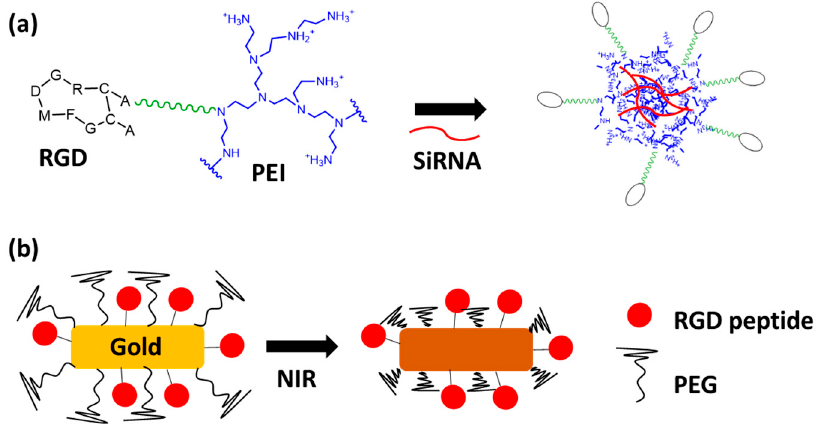
Figure 3. Structures of RGD NPs: ( a ) SiRNA-containing RGD–polyethyleneimine NP [46]; ( b ) RGD– Gold NP with PEG corona [67].